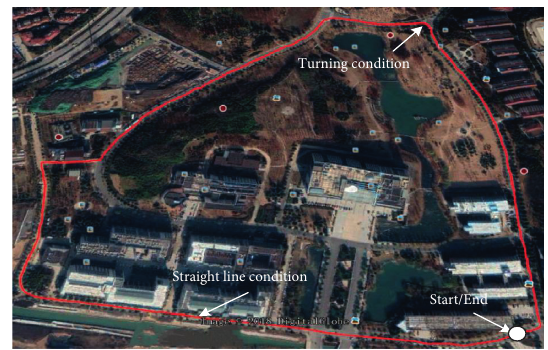
Figure 15: Road map of the test.